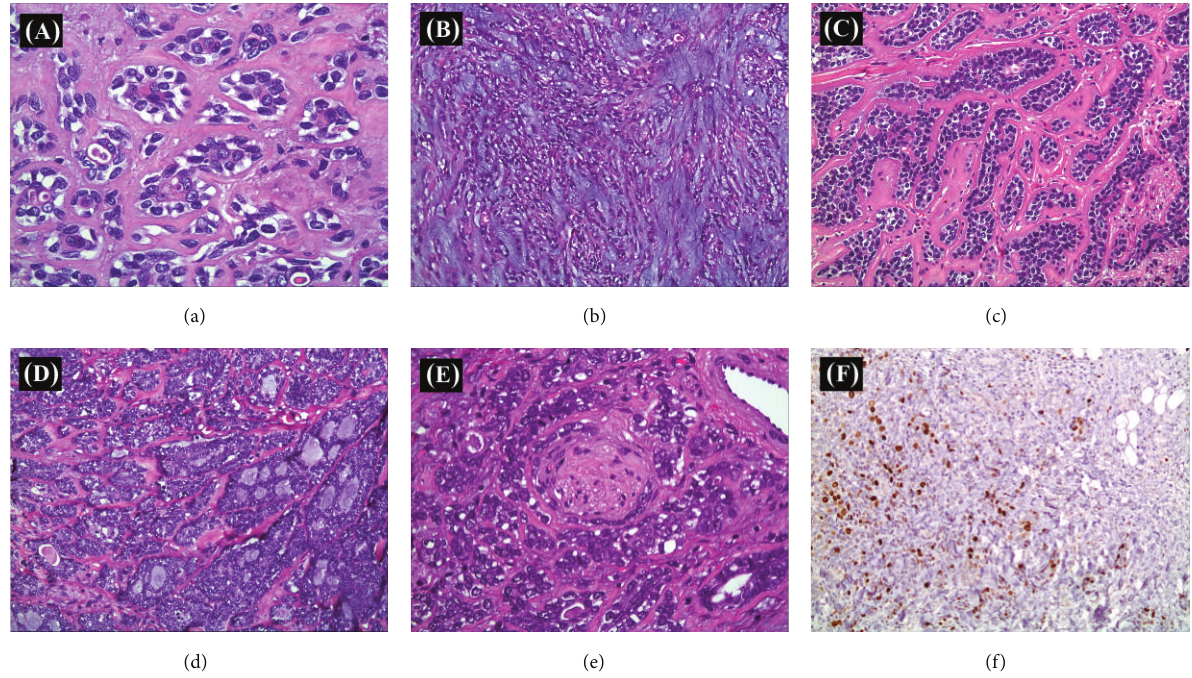
Figure 2: (a) Epithelial-myoepithelial carcinoma. The ductal structures are composed of outer layer of polygonal, clear myoepithelial cells with variable sized and shaped nuclei. The central epithelial cells are smaller and have eosinophilic cytoplasm, round to oval nuclei, and a high nuclear to cytoplasmic ratio. (b) Focally, the epithelial-myoepithelial carcinoma component exhibits myxochondroid rich background with anastomosing stands of epithelial cells reminiscent of pleomorphic adenoma morphologically. (c) Basal cell adenocarcinoma: prominent eosinophilic hyaline material is seen around nodules of tumor composed of small cells with more chromatic nuclei around larger cells with paler nuclei. (d) Adenoid cystic carcinoma: tubular and cribriform and solid tumor nests. Basal lamina-containing cyst-like spaces are noted. The tumor cells show high grade cytology with markedly increased nuclear to cytoplasmic ratio. (e) Nests of tumor invading the peripheral portion of the nerve bundle in the areas dominated by adenoid cystic carcinoma. (f) The proliferative index by Ki-67 stain labeling showed significantly higher labeling index in the adenoid cystic component (lower left corner) in comparison to the epithelial-myoepithelial component (upper right